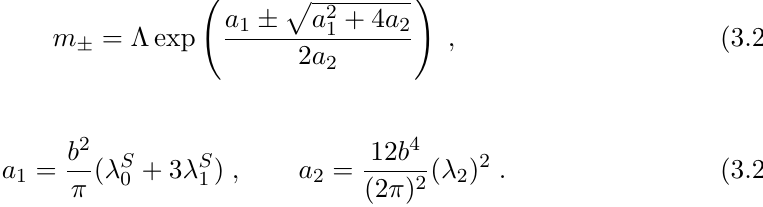
Figure 6 . Structure of the leading contributions to the one-loop beta function of (cid:21) are suppressed by a factor of 1 =N with respect to the natural scaling of (cid:21) 2